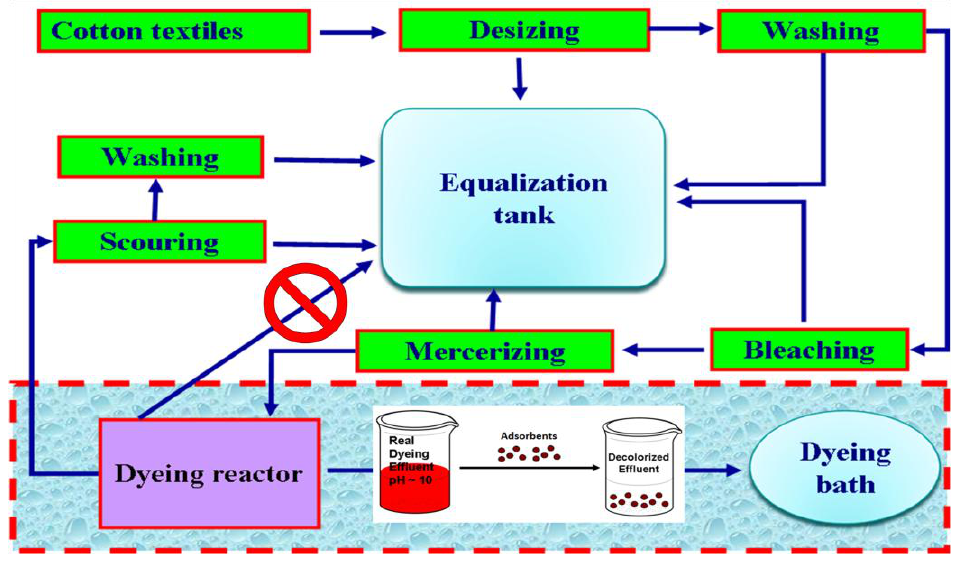
Figure 2. Treatment of textile wastewaters